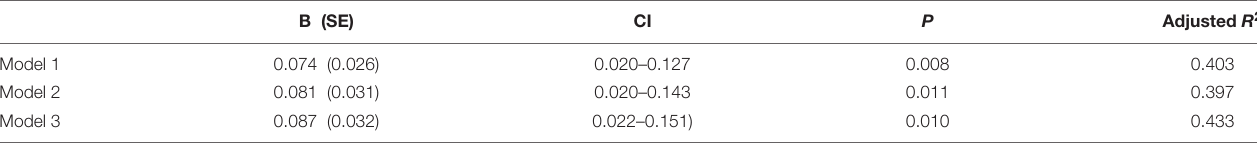
TABLE 4 | The results of multiple linear regression analyses assessing the associations between the serum copper level and MMSE in MCI older adults. B (SE) CI P